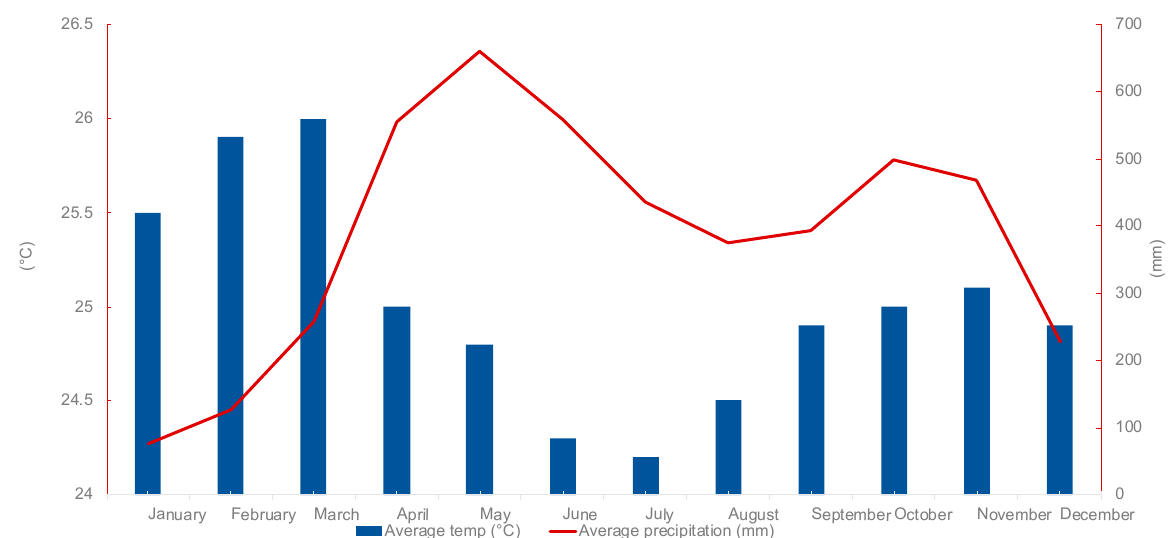
Figure 2. Climadiagram of the Acacias River Basin in the Piedemonte Llanero of Colombia.